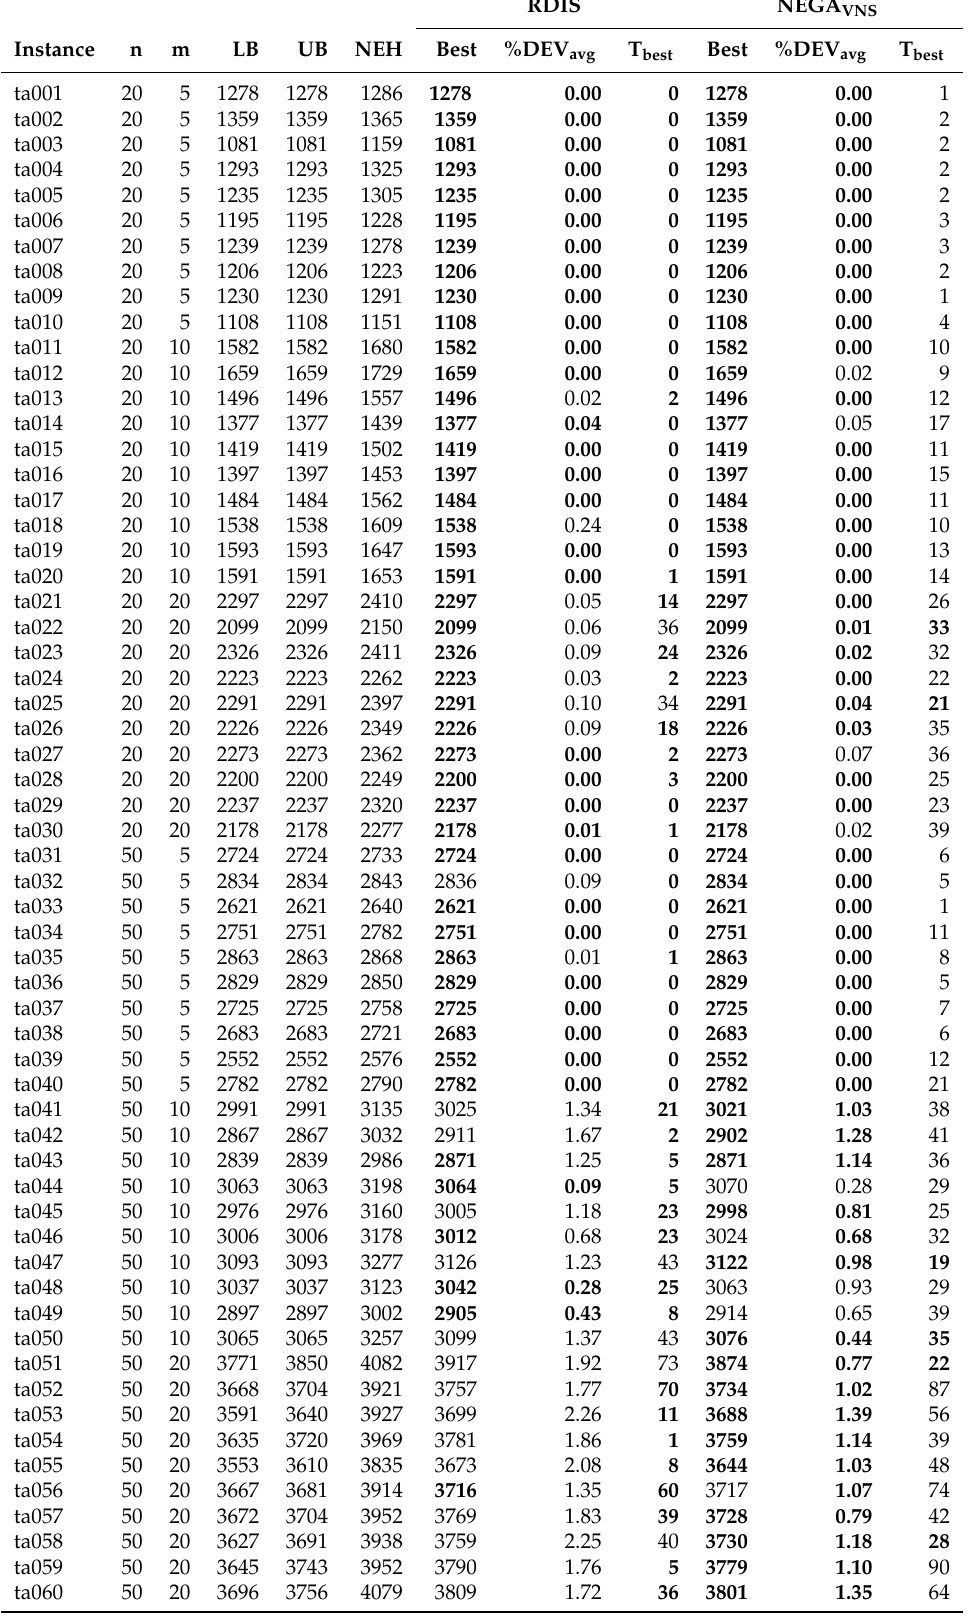
Table 6. Comparing the performance of the RDIS with that of NEGA VNS for all individual